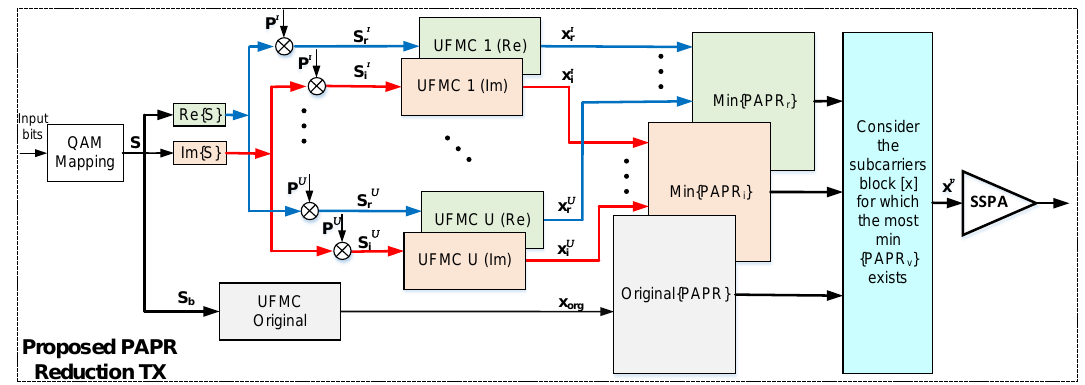
Figure 2. The proposed block diagram of Dcomp-selected mapping (SLM) UFMC peak-to-average power ratio (PAPR) reduction